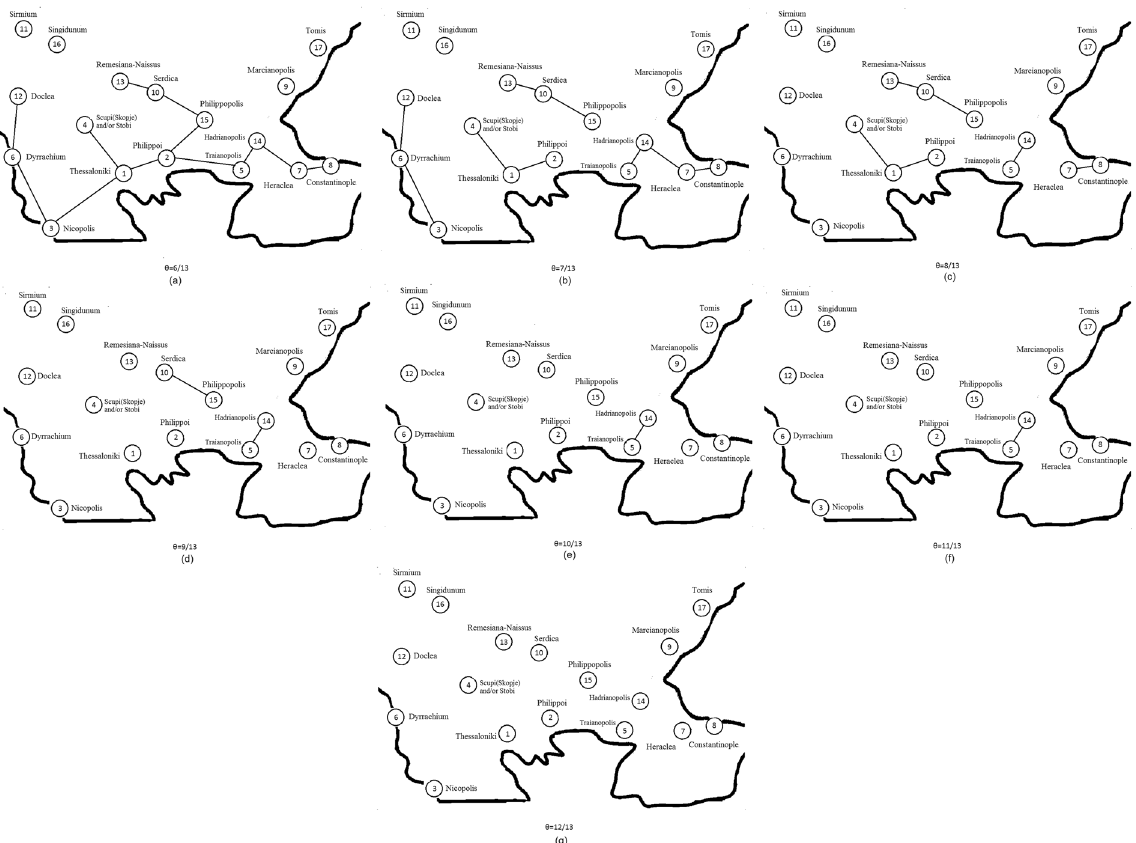
Figure 5. Generalized Physarum graphs P ( θ ) 6 ≤ θ ≤ 12 (Figure from Microsoft paint v. 1607 and data points from Matlab v. R2011b by author